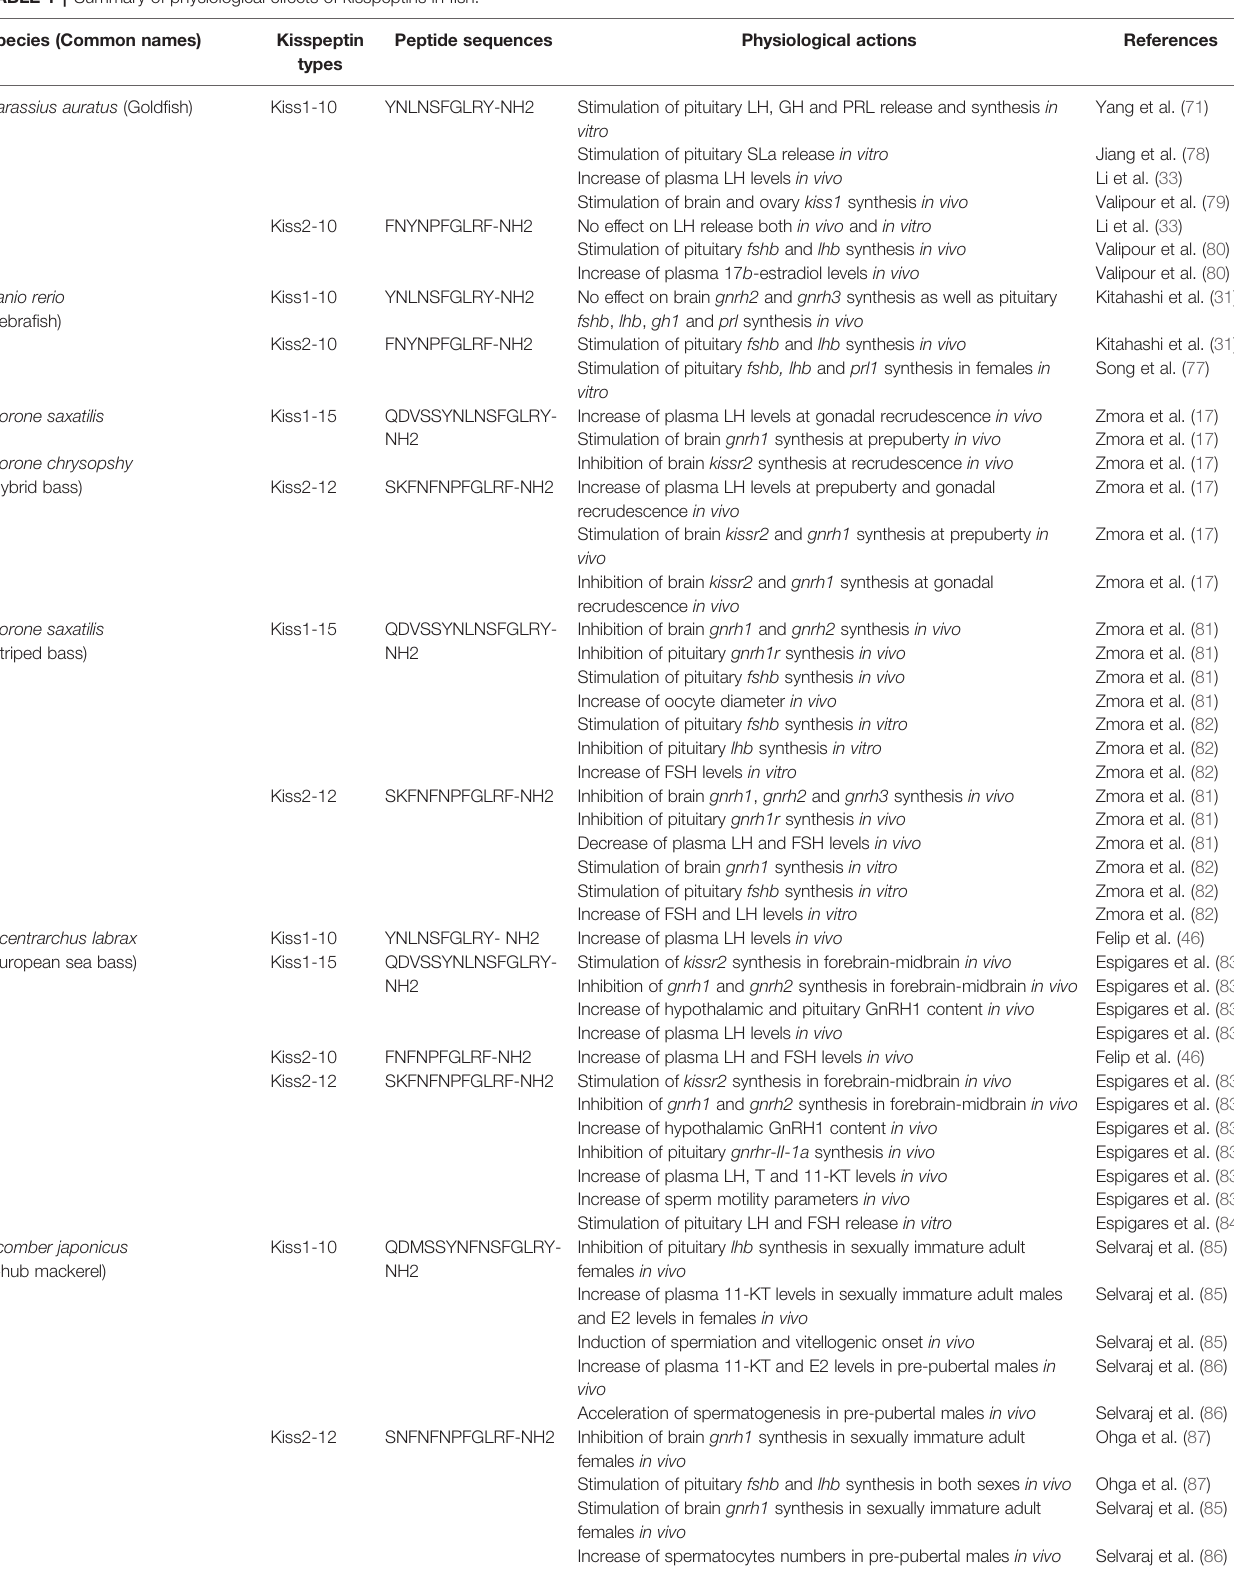
TABLE 1 | Summary of physiological effects of kisspeptins in fi